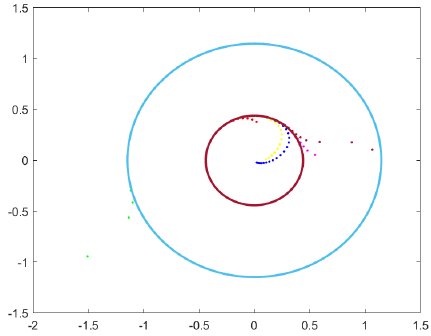
+ α + α 2 , β 2 ( α ) = 1 α 2 2 1